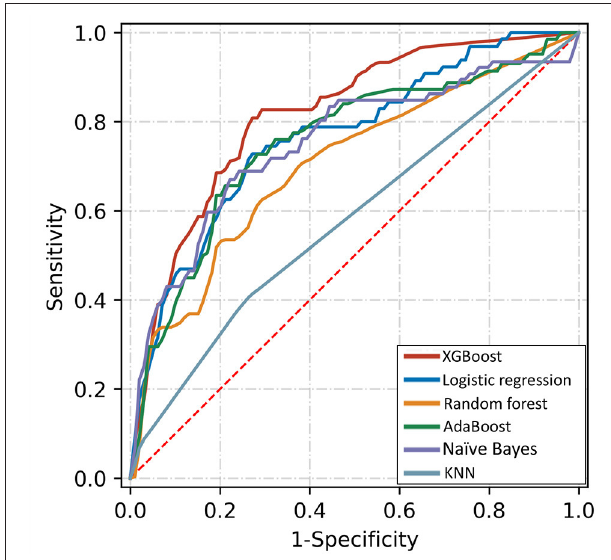
FIGURE 4 | Receiver operating characteristic curves of five algorithms for detecting referable diabetic retinopathy based on top-10 important variables.